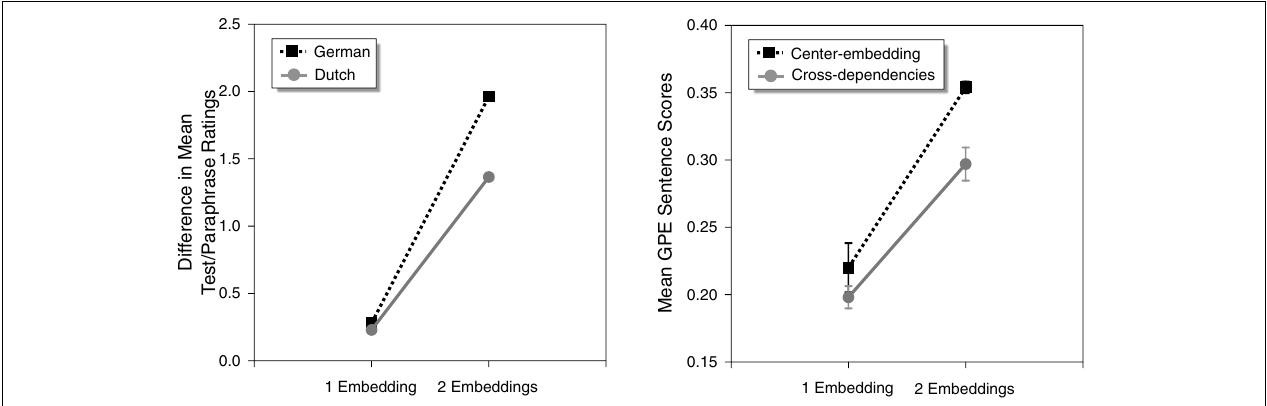
FIGURE 2 | Human performance (from Bach et al., 1986) on center-embedded constructions in German and cross-dependency constructions in Dutch with one or two levels of embedding (left). SRN performance on similar complex recursive structures (from Christiansen and MacDonald, 2009) (right) .